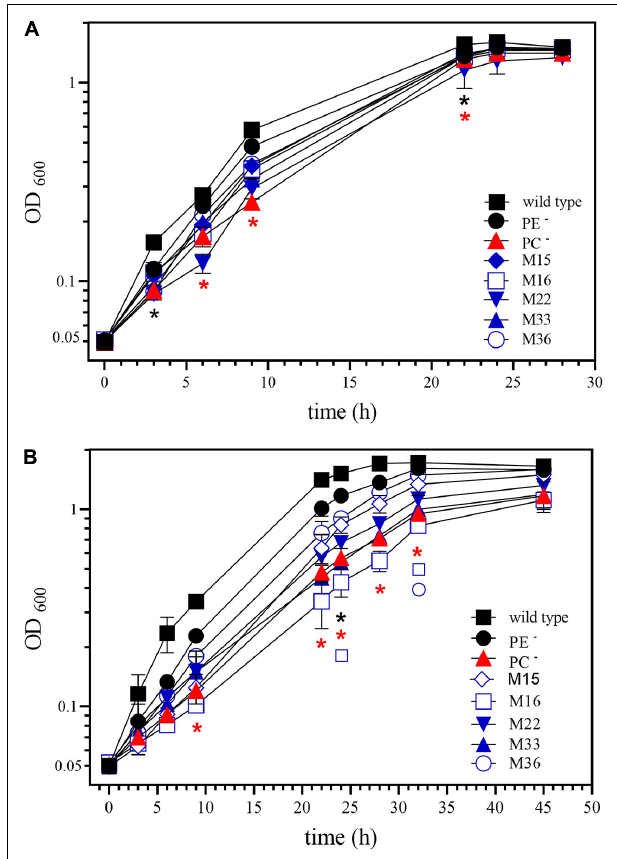
FIGURE 7 | Phosphatidylcholine (PC)-deficient mutant OG10017 is severely impaired in growth on slightly acidic media. Growth of S. meliloti wild type strain 1021 ( (cid:110) ), phosphatidylethanolamine (PE)-deficient mutant CS111. ( (cid:108) ), PC-deficient mutant OG10017 ( ), and the correlated suppressor mutants M15 ( ), M16 ( ), M22 ( ), M33 ( ), M36 ( ) was recorded on LB/MC+ medium containing 20 mM Bis-Tris methane, pH 7.0 (A) or on LB/MC+ medium containing 20 mM Bis-Tris methane, pH 5.75 (B) by measuring the optical density of cultures at 600 nm (OD 600 ). Values represent means of three independent experiments and standard deviation is shown. Statistical analysis was performed by a two-way ANOVA with Tukey’s multiple comparisons test as described in Materials and Methods. Comparisons of the PE-deficient (black asterisks) or the PC-deficient (red asterisks) mutant to wild type are indicated. Statistical significance is shown (* p < 0.05). Also indicated are statistically significant comparisons between the PC-deficient mutant and correlated suppressor mutants M16 ( ) and M36 (